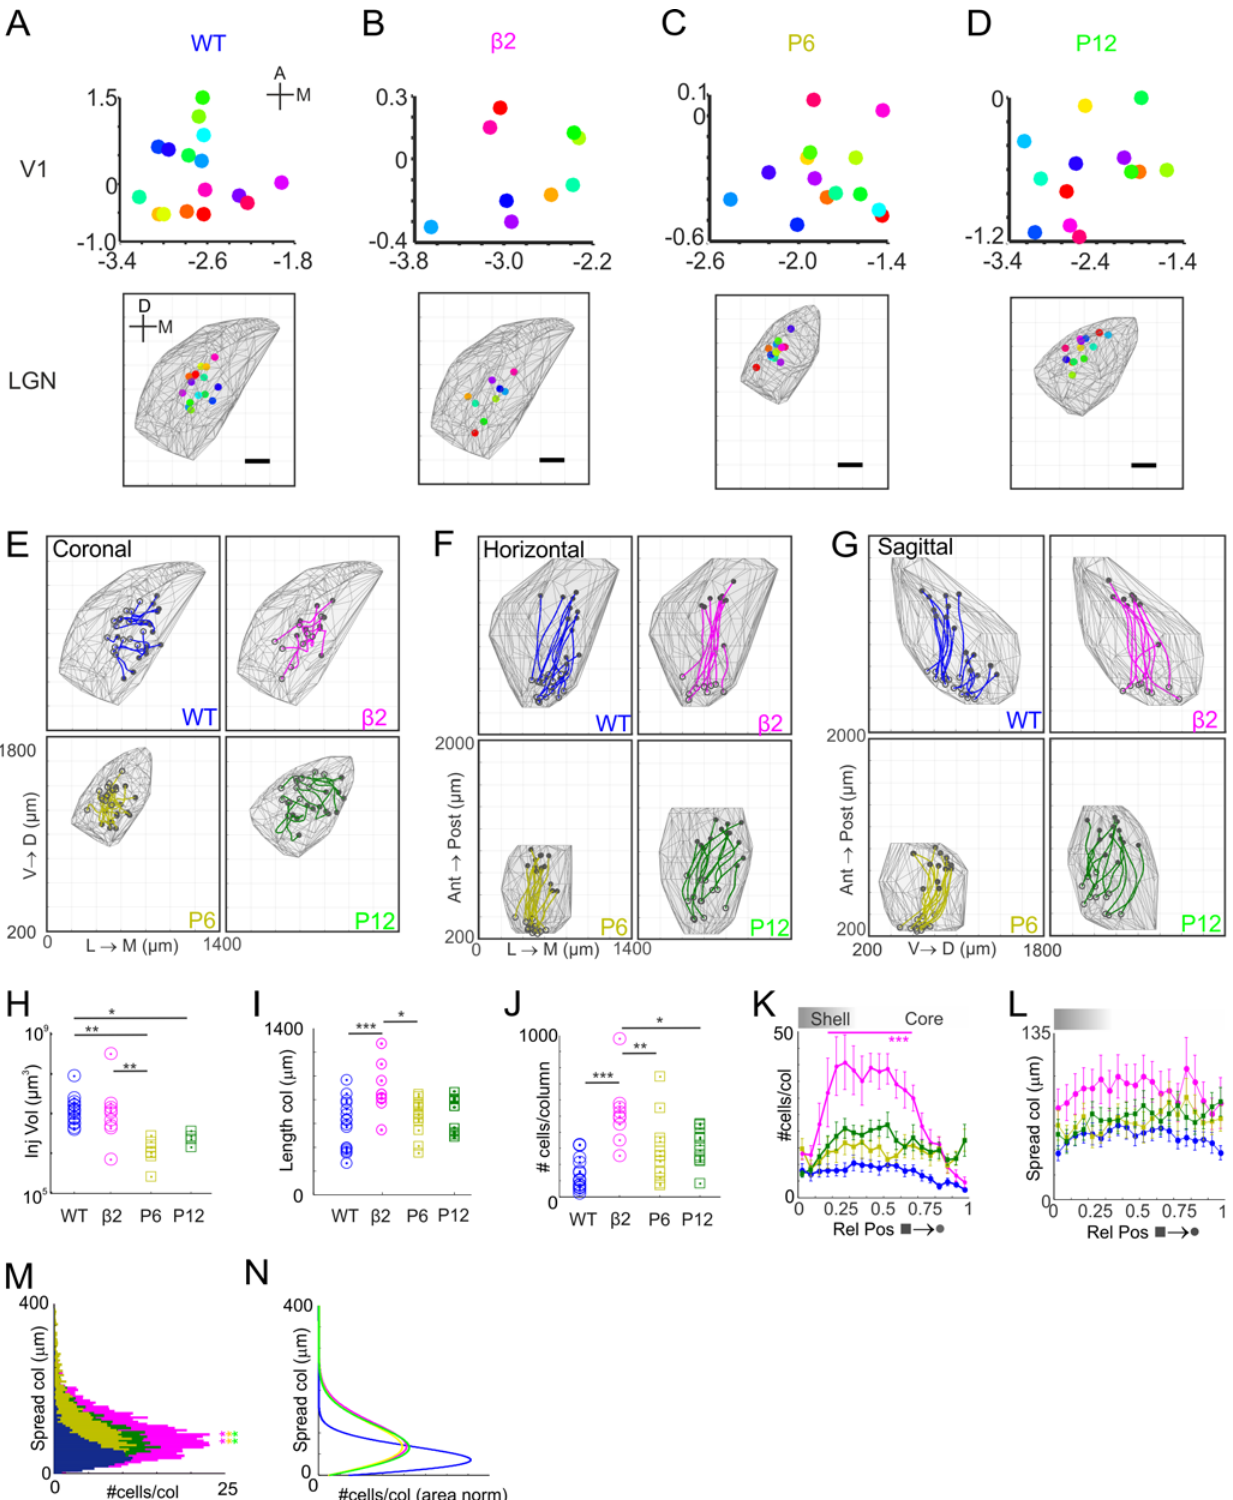
Fig 2. Form and Features of dLGN-V1 Projection Columns. (A-D) Location of V1 injections (mm relative to Lambda) and positions of the labelled column on the pial surface (scale bar 200 μ m) for four groups: Adult Wild Type (WT), n = 16; Adult β 2 -/- , n = 9; P6 WT, n = 14, P12 WT, n = 13. Coordinates are relative to lambda. (E-G) Reconstructed paths of dLGN-V1 projection columns collapsed onto coronal (E), horizontal (F), and sagittal (G). Columns extend from the